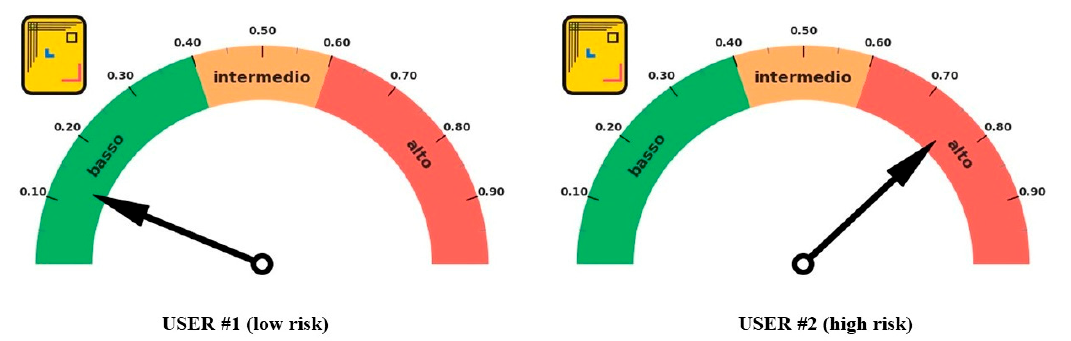
Figure 6. Dress-COV: examples of individual reports about the risk of being a Covid-19 case.